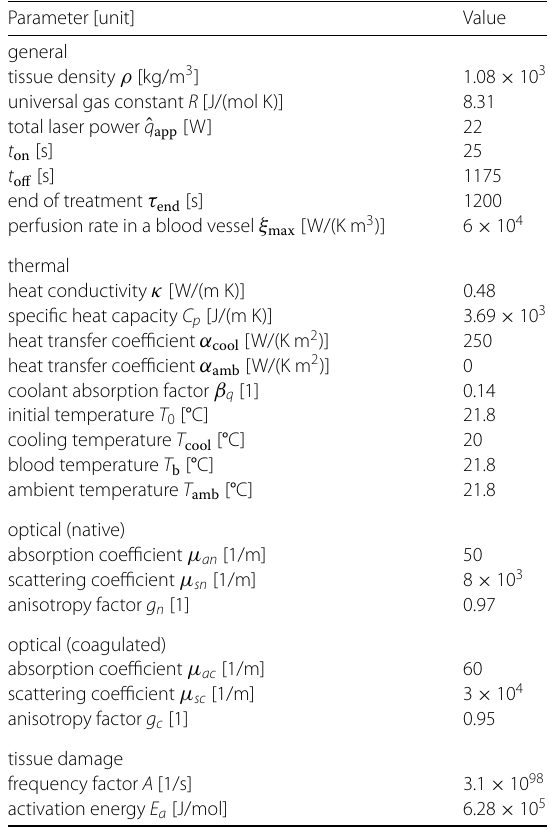
Table 1 Values for the various parameters of the liver